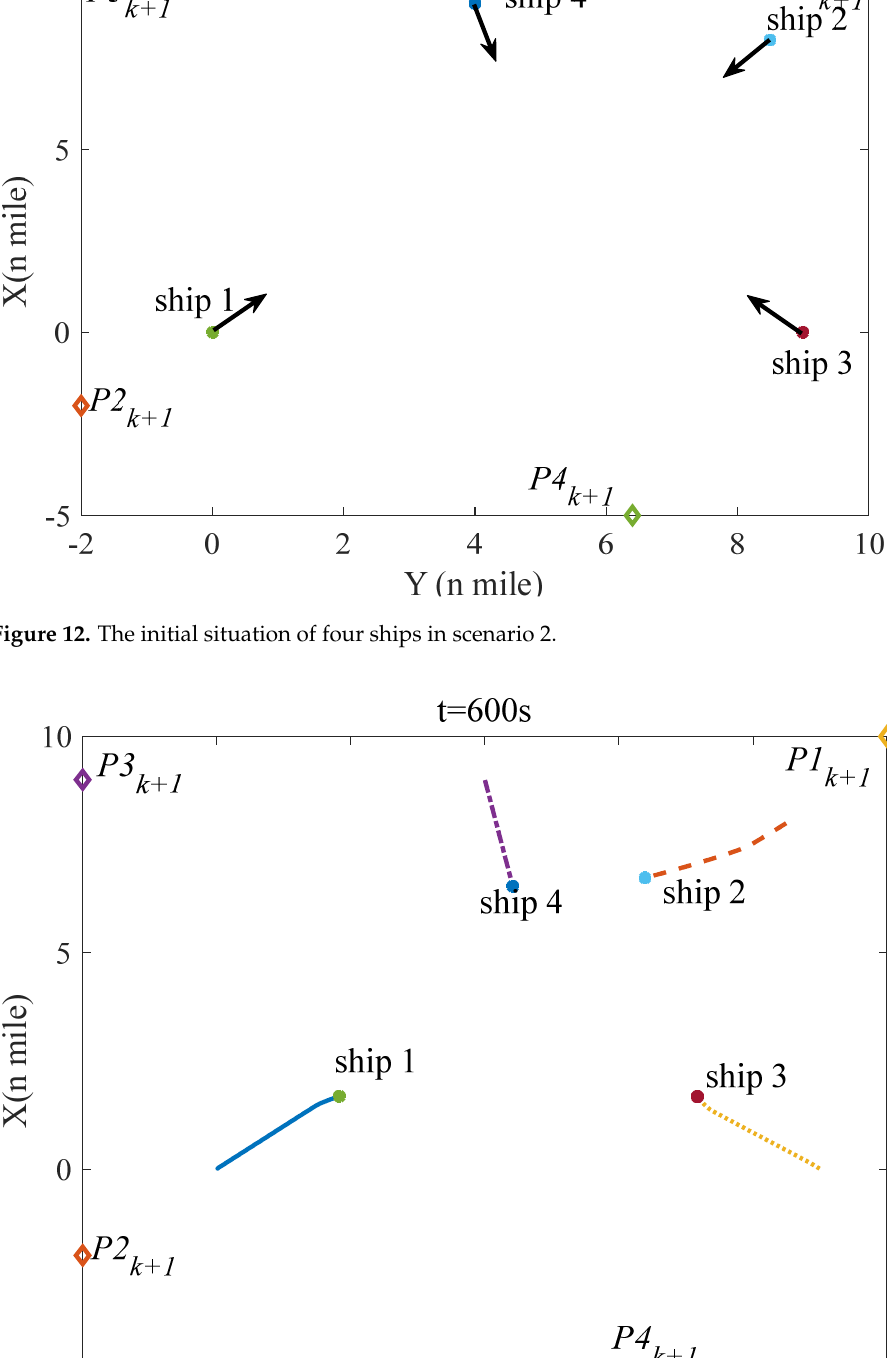
Figure 14. The situation of four ships at t = 1200 s in scenario 2. Figure 15. The situation of four ships at t = 2400 s in scenario 2.